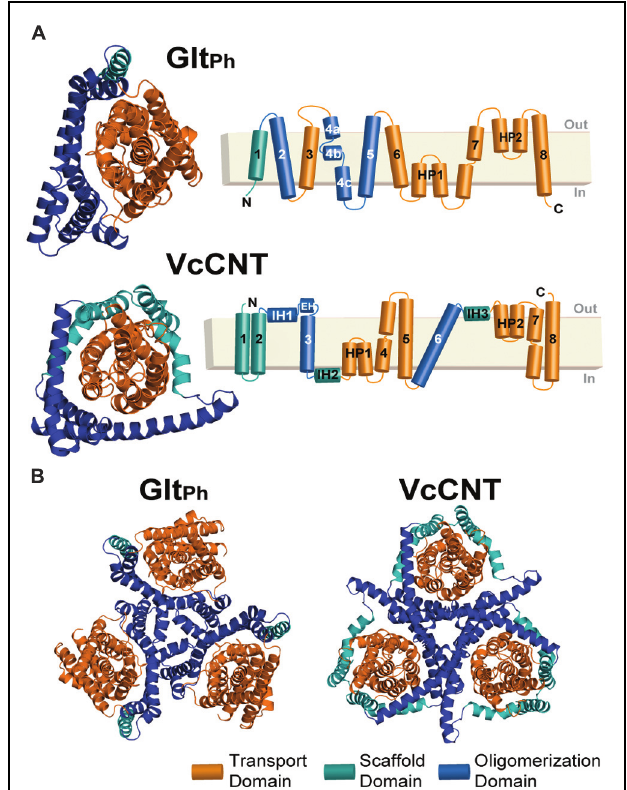
FIGURE 1 | Structure of the Glt Ph and VcCNT transporters. (A) Cartoon representation of the Glt Ph (top) and VcCNT (bottom) protomer structures shown from the extracellular side of the membrane (left). HP, helical hairpin; IH, interfacial helix; EH, extracellular helix. In both proteins, the transport domain is colored orange. The scaffold domain is colored cyan and blue, with the blue regions indicating helices involved in oligomerization. The helices forming each domain are detailed in the topology diagrams to the right. (B) Trimeric structures of Glt Ph (left) and VcCNT (right) shown from the extracellular side of the